Question: Draft a figure caption describing what is shown.
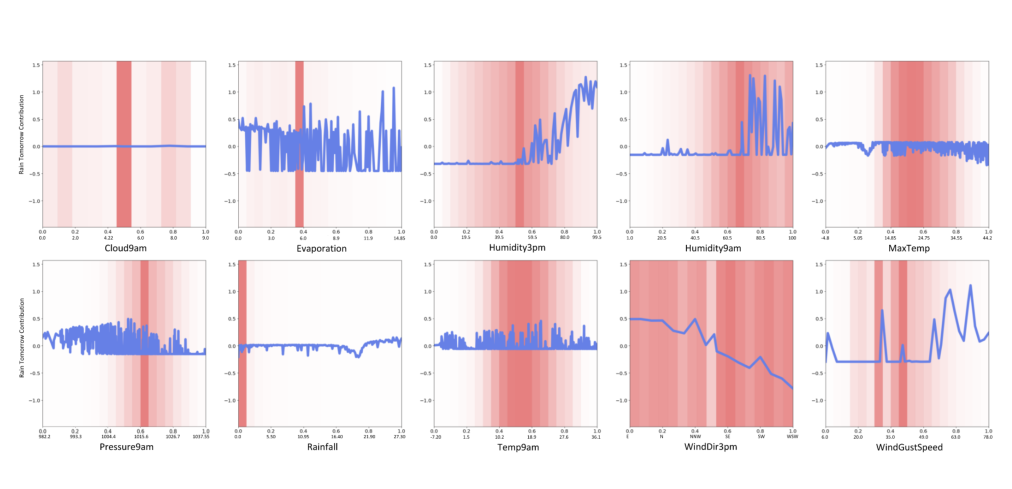
Answer: Weather Graphs learned by FocusLearn in predicting whether it will rain tomorrow (classification) on the Weather dataset. These plots show top 10 features selected by the AFS component in the FocusLearn, where selected features with normalised and original values are on the x-axis, and contribution towards the prediction are on the y-axis.